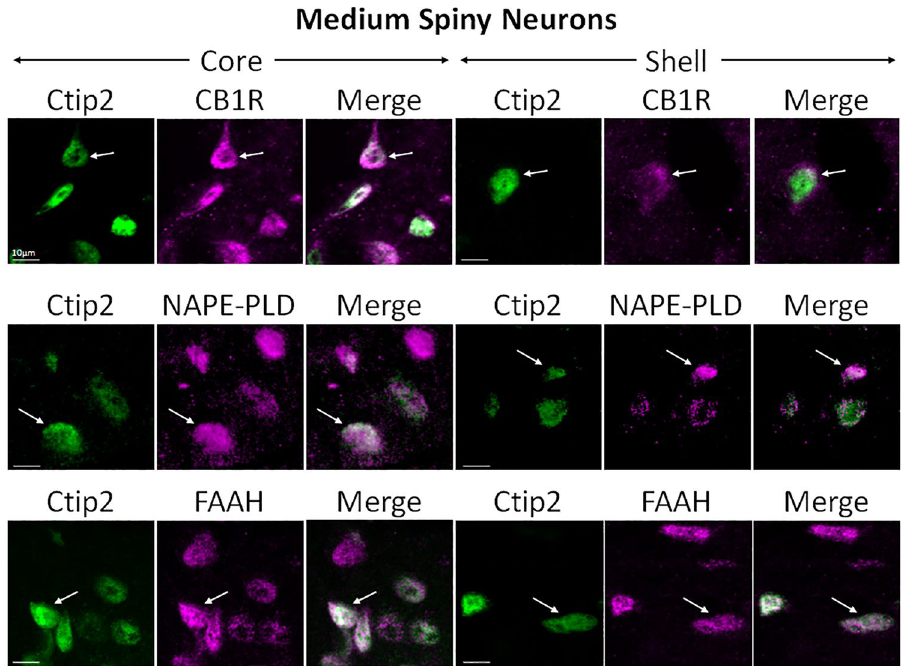
Figure 4. Double-label immunofluorescence illustrating co-localization of CB1R-IR, NAPE-PLD-IR, and FAAH-IR with Ctip2. Confocal micrographs of NAc co-immunolabeled for CB1R, NAPE-PLD, or FAAH (magenta), and Ctip2 (green), a specific marker for MSNs, in core and shell. Arrows point at Ctip2-positive MSNs that express either CB1R, NAPE-PLD, or FAAH. Scale bar = 10 µ